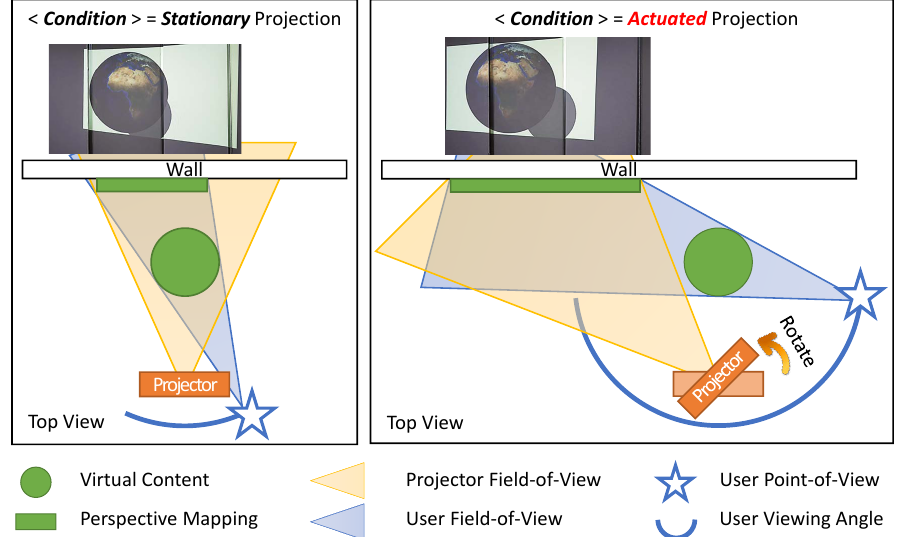
Figure 6. The schematic comparing the stationary and actuated projection. Note that both projection mappings are user-perspective rendered. Actuated projection mapping with pan–tilt servos greatly widens the viewing angle in a virtual scene, as more regions of the Middle East Asia region are revealed before the earth goes out of the projection range. Front and rear cameras are omitted for